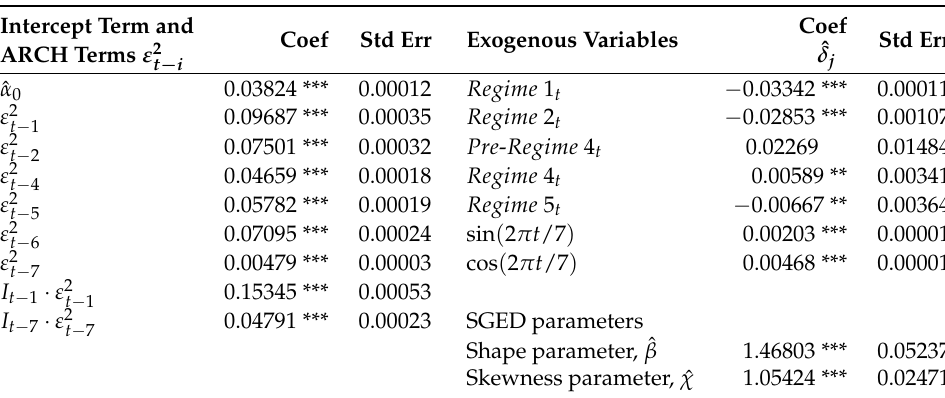
p (cid:16) ∑ + γ i I t α i ε 2 t i − i = 1